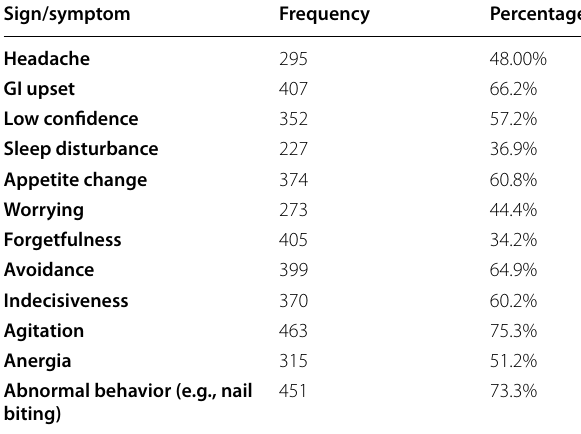
Table 4 Frequency and percentage of the manifestations of stress among Sudanese medical students